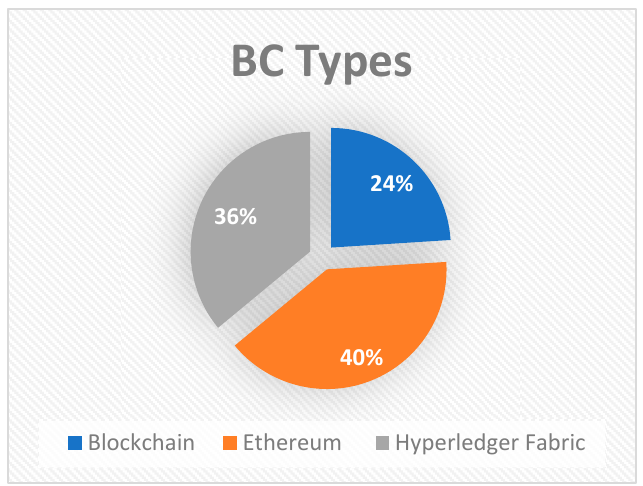
Figure 3. Blockchain Types.